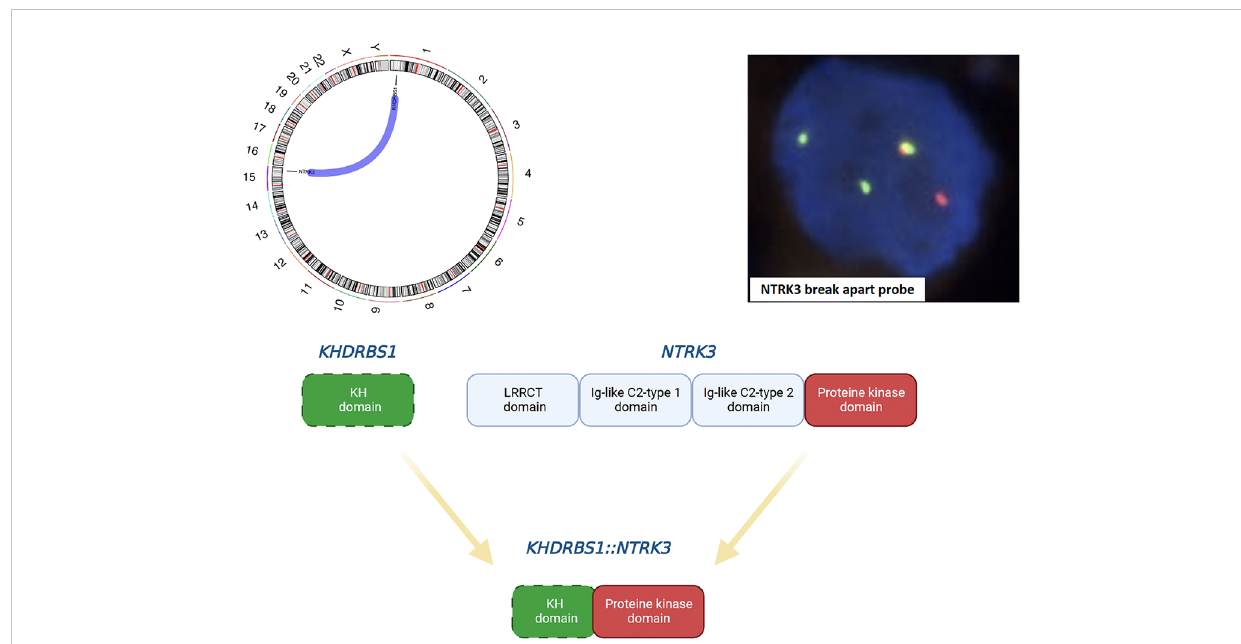
FIGURE 2 Schematic illustration of the in-frame KHDRBS1-NTRK3 fusion (Circos plot and schematic diagram were created using MAFTOOLS and Biorender, respectively) and con fi rmation using the NTRK3 break apart FISH probe. The following breakpoints were identi fi ed using the FusionCatcher software: chr1:32039573A and chr15:88033045 for KHDRBS1 and NTRK3 , respectively.